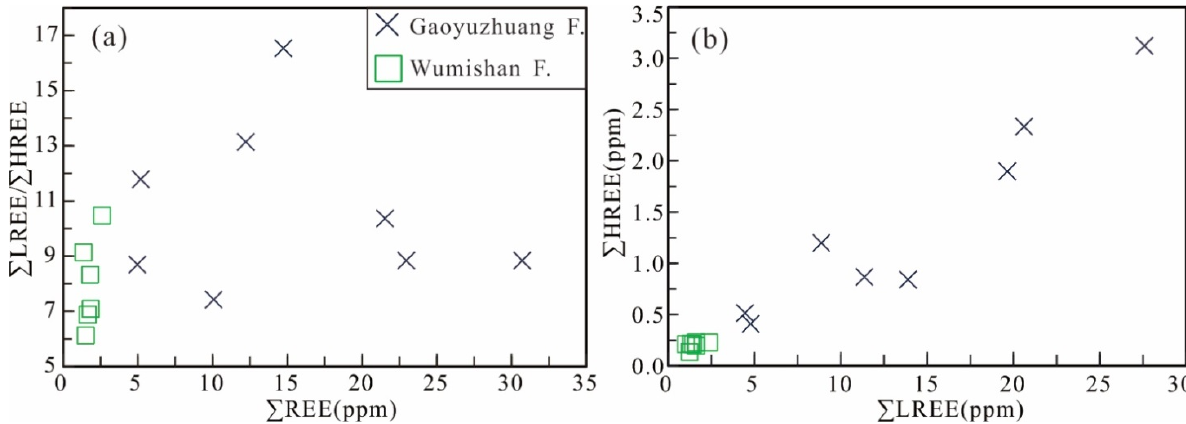
Figure 6. Plots of ( a ) Σ REE versus Σ LREE/ Σ HREE and ( b ) Σ LREE versus Σ HREE for the carbonate rocks from the Gaoyuzhuang and Wumishan Formations.